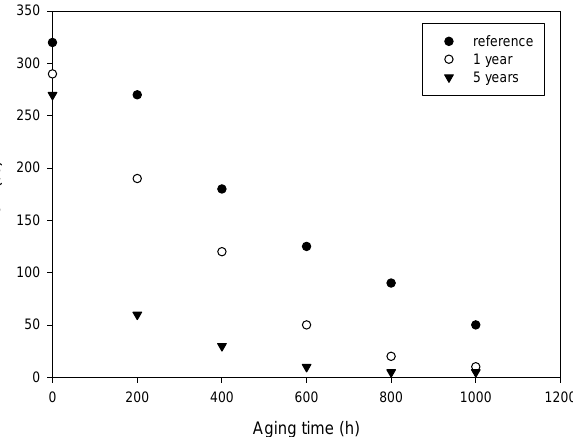
Figure 7. EaB of post-irradiated cable aged at 85 °C and 0.42 kGy/h measured immediately after aging (reference), after 1 year and 5 years.